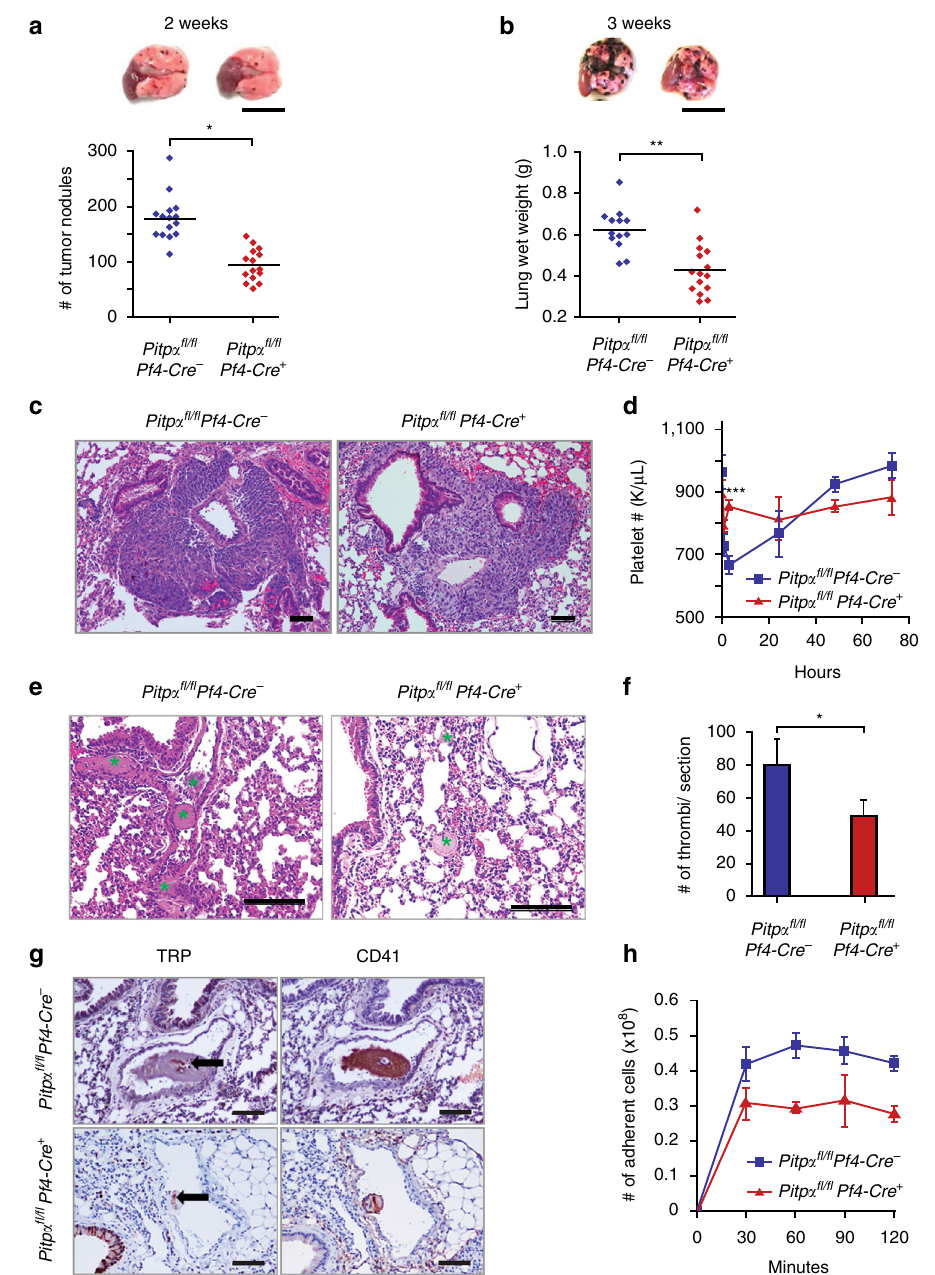
Fig. 3 Loss of PITP α in platelets impairs tumor metastasis formation. a The lungs derived from Pitp α fl / fl Pf4-Cre − and Pitp α fl / fl Pf4-Cre + mice harvested 2 weeks after tail vein injection with B16F10 melanoma cells. Shown are representative lungs. The number of tumor nodules on the lung surface was reduced in Pitp α fl / fl Pf4-Cre + mice when compared with Pitp α fl / fl Pf4-Cre − controls. Scale bar is 10 mm. * p < 0.0001, unpaired Student ’ s t -test. b Similarly, 3 weeks after tumor injection, the lungs of the Pitp α fl / fl Pf4-Cre + mice contained less metastasis than the Pitp α fl / fl Pf4-Cre − mice as indicated by their weights. Scale bar is 10 mm. ** p < 0.0001, unpaired Student ’ s t -test. c H&E staining of tumors in lung tissue sections at 3 weeks after tumor injection show no signi fi cant fi brosis or hemorrhage. Black scale bars represent 100 µ m. d Shown are serial platelet counts analyzed after tumor injection. Control mice have an abrupt decrease in their platelet counts 3 h after tumor injection. This reduction was markedly blunted in the Pitp α fl / fl Pf4-Cre + mice ( n = 6 for each genotype, *** p < 0.05, unpaired Student ’ s t -test). Shown are the means ± s.d. e H&E staining for lung tissues at 3 h after tumor cell injection demonstrated tumor-induced thrombi formation within lung tissue. The stars indicate the tumor-induced thrombi. Black scale bars represent 200 µ m. f Quanti fi cation of CD41-positive thrombi formation observed within lung tissue of the Pitp α fl / fl Pf4-Cre + mice ( n = 4) and the Pitp α fl / fl Pf4-Cre − control mice ( n = 5). *** p = 0.02, unpaired Student ’ s t -test. Error bars are s.d. g Immunohistochemistry analysis of tumor-induced thrombi in lung tissues at 3 h after tumor injection staining for CD41 (platelet marker) and TRP1 (B16F10 tumor cells). The arrows indicate the tumor cells. This demonstrates that the tumor cells are coated with large clusters of platelets in the Pitp α fl / fl Pf4-Cre − mice. This phenomenon was less frequently found in the Pitp α fl / fl Pf4-Cre + mice. Black scale bars represent 100 μ m. h Ex vivo adhesions of platelets on tumor cell layers indicate impaired interactions between Pitp α fl / fl Pf4-Cre + platelets and tumor cells. N = 3 mice per group. Shown are the mean ± s.d. for all fi gure